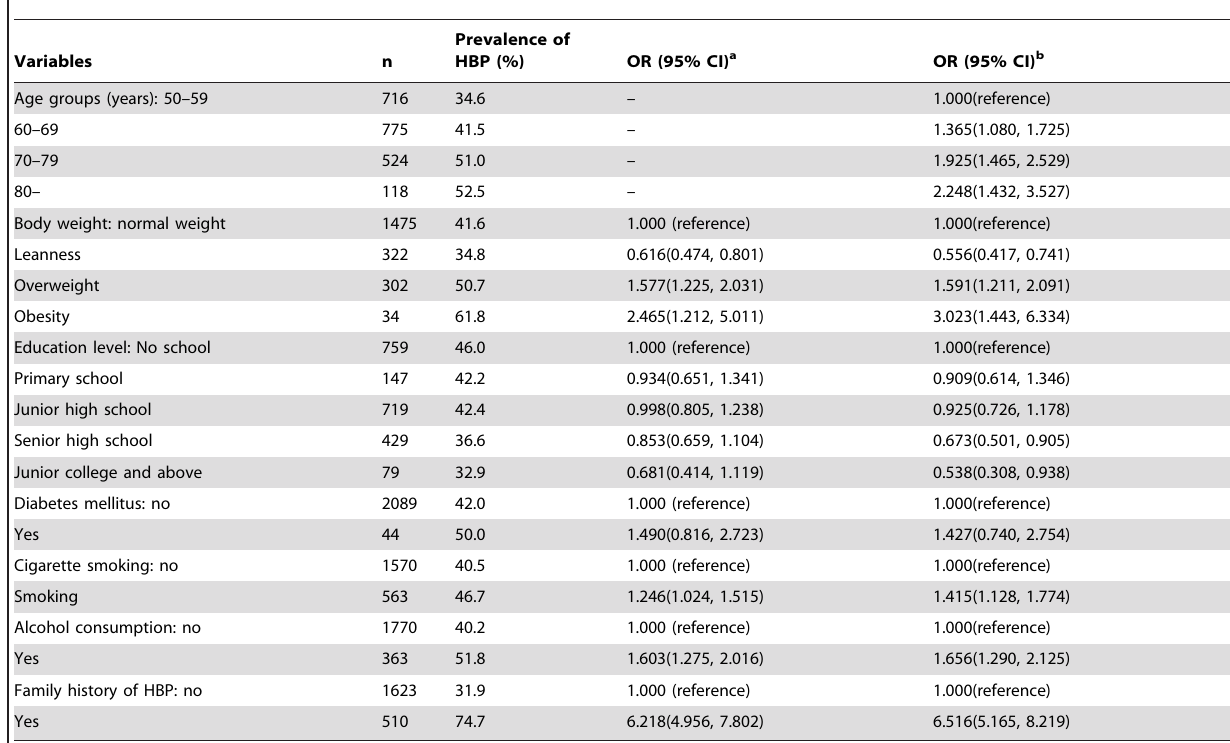
Table 3. Factors associated with the prevalence of hypertension from multivariate logistic regression models (N= 2133).